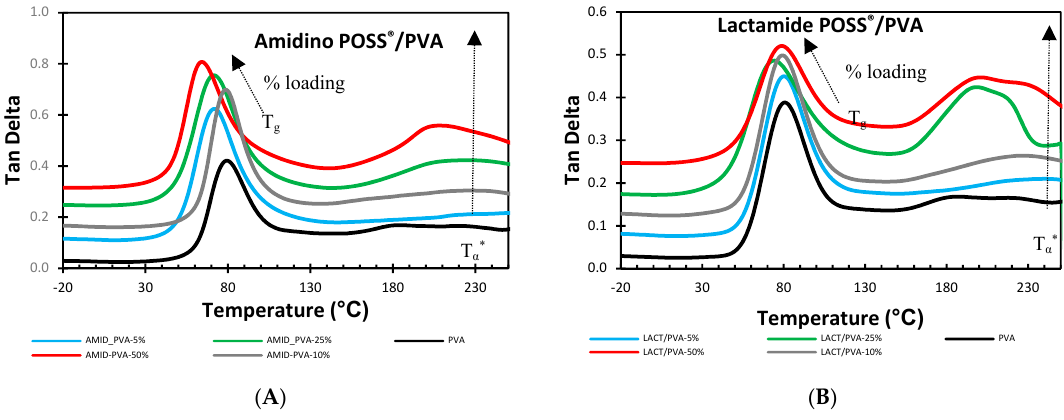
Figure 9. DMA analysis of Amidino POSS ® /PVA ( A ); Lactamide POSS ® /PVA ( B ). PVA (black), 5% (blue), 10% (gray), 25% (green), 50% (red). The curves are shifted vertically for clarity.